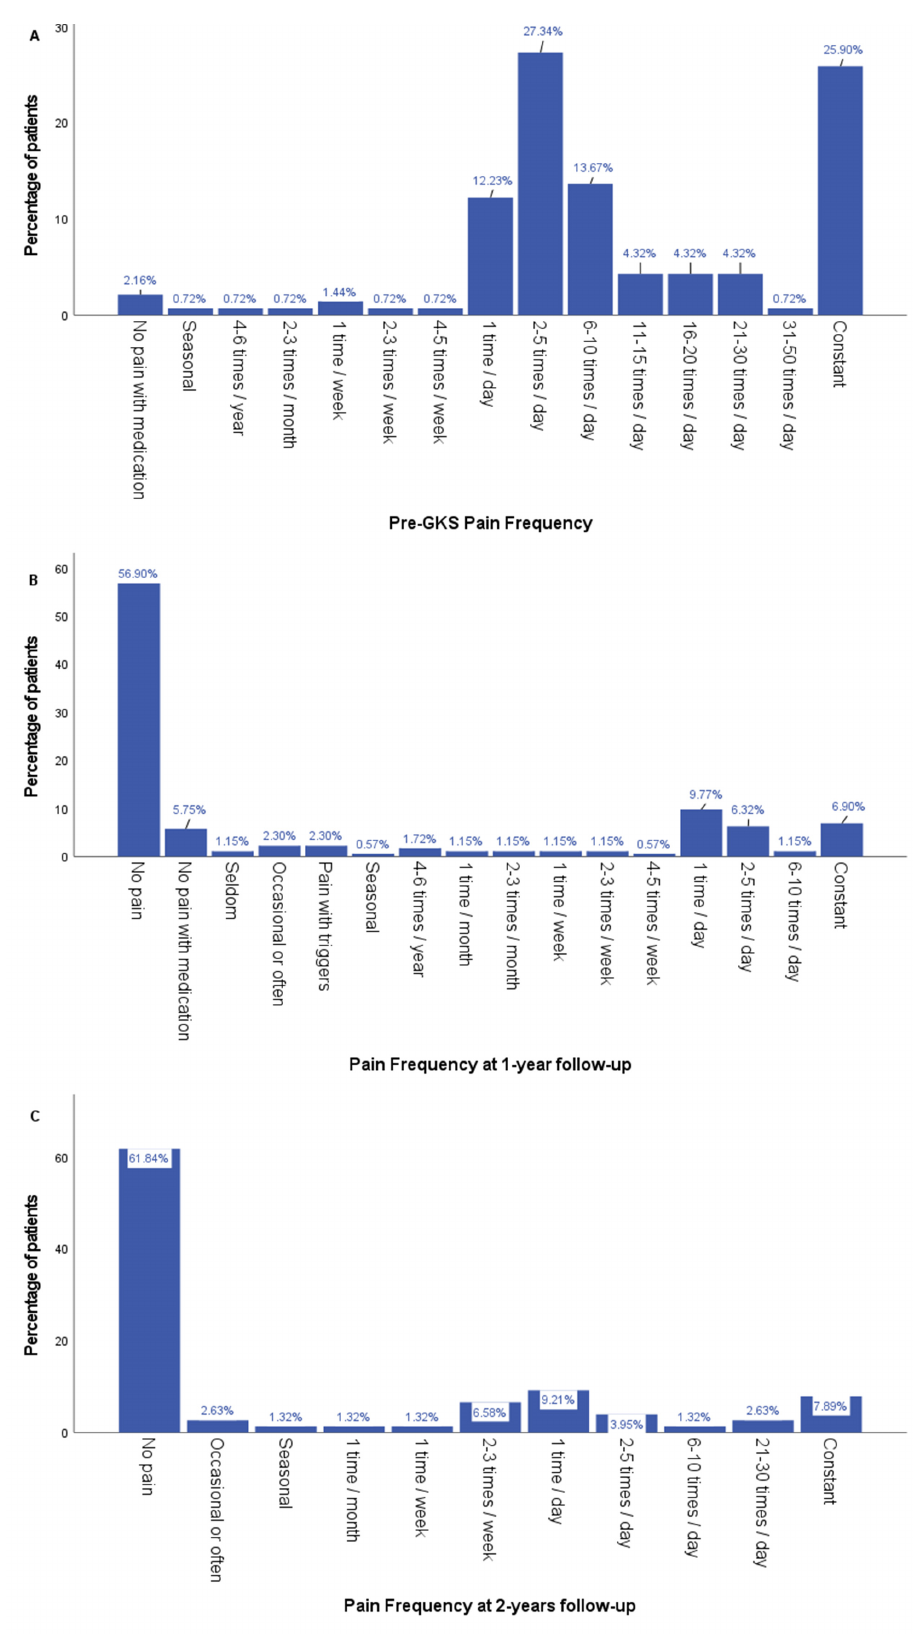
Figure 5. Pain frequency before GKSRS ( A ), and at the 1-year ( B ) and 2 years ( C ) follow-up